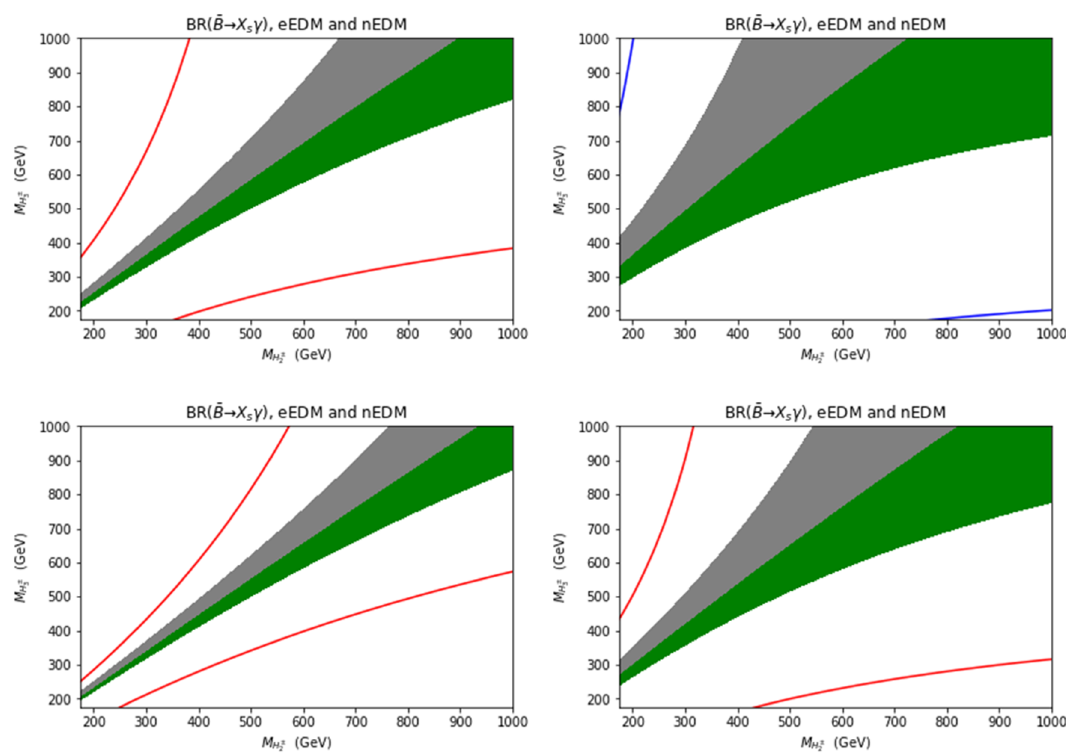
Figure 19 . Same as figure 17 but with δ = 0 . 9 π